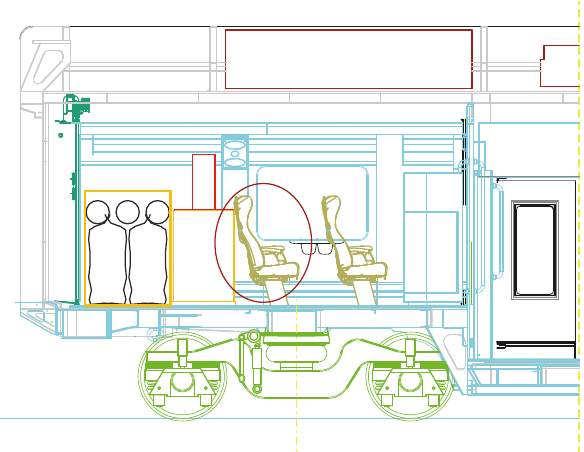
Figure 19: Position of the sensors (red circles) on the ground floor over the rear